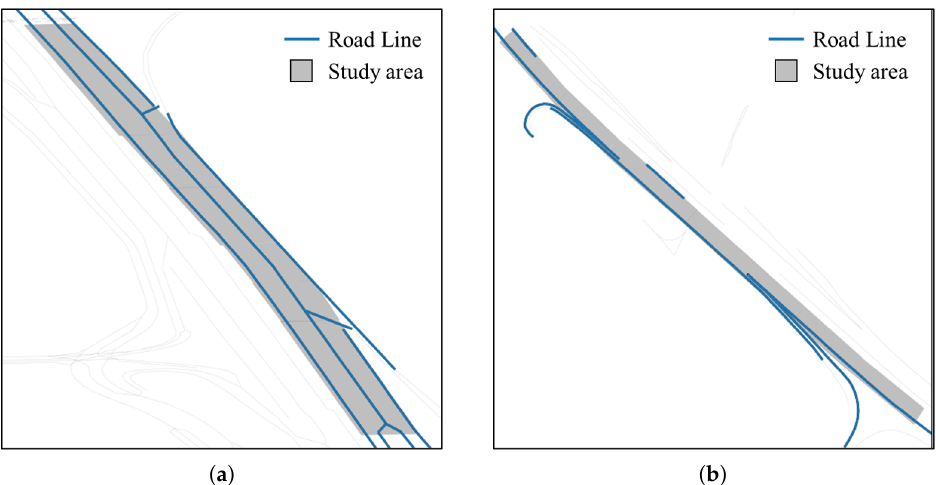
Figure 5. Highway maps of the study area based on the geometry and attributes contained in the GIS